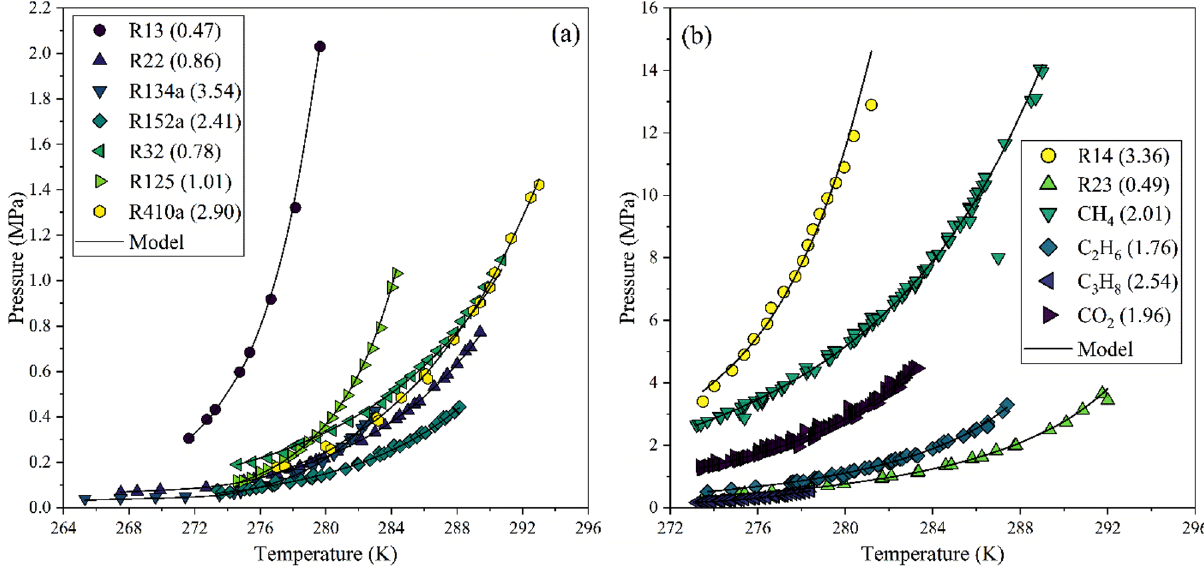
Figure 2. Model estimates of phase equilibrium conditions compared to the experimental data of chlorofluorocarbon (R13 40 ), hydrochlorofluorocarbon (R22 42–45 ), hydrofluorocarbon (R23 40–42,46 , R32 49,50 , R125 42,49,50 , R134a 42,47–50 , R152a 40,48 , R410a 42,47–50 ), perfluorocarbon (R14 41 ), and CH 4 7 , C 2 H 6 7 and C 3 H 8 7 and CO 2 7 hydrates in pure water. The number in parenthesis against each legend quantifies the model %AARD in pressure.